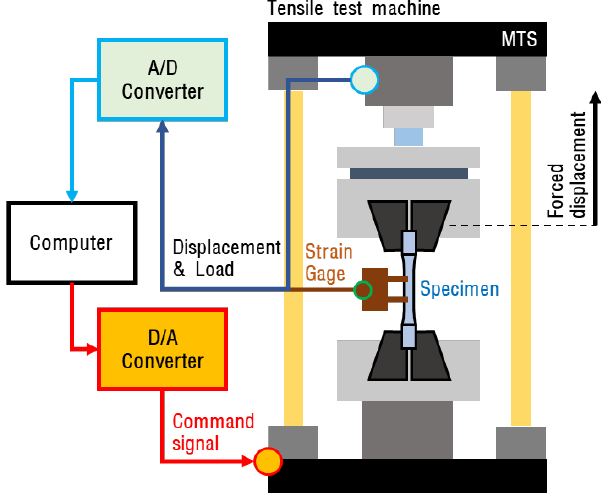
Figure 2. Schematic of the ASTM E8/E8M tensile test.